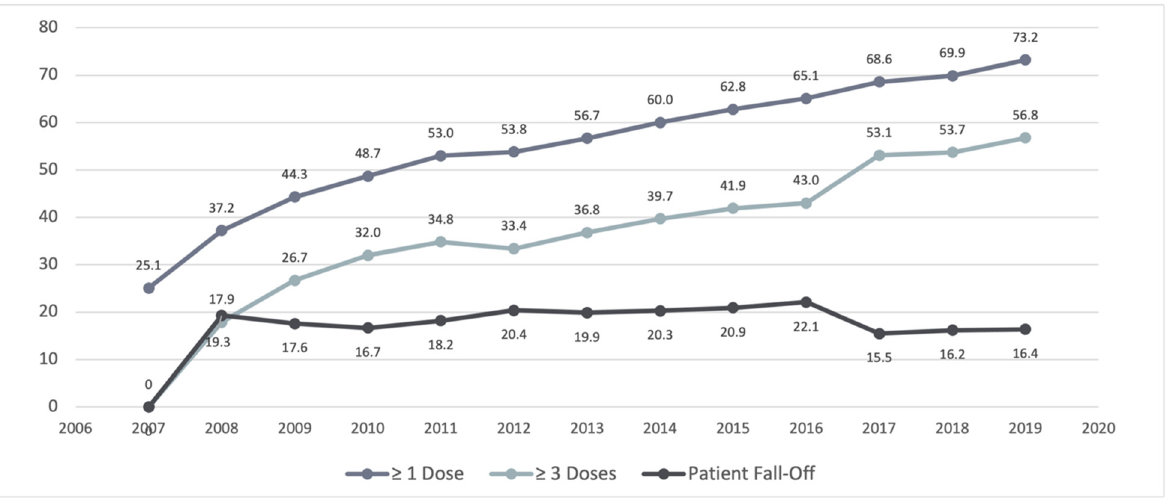
Figure 2. Estimated HPV vaccine coverage (by percentage) among adolescents aged 13–17 by year, dose, and patient fall-off/incompletion-NIS Teen 2007–2019.